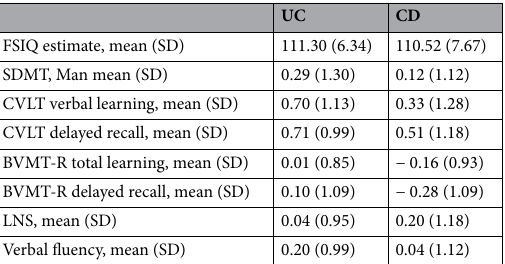
Table 3. Cognitive functioning results for UC vs. CD. FSIQ Full Scale Intellectual Quotient, SDMT Symbol Digits Modality Test, CVLT California Verbal Learning Test, 2nd Ed., BVMT-R Brief Visualspatial, Test – Revised, LNS Letter Number Sequencing Test.